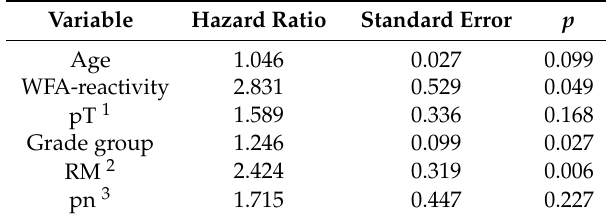
Table 4. Multivariate analysis to determine an independent predictor of PSA